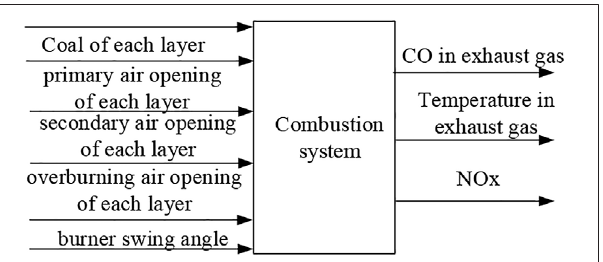
FIGURE 2 | Input and output variables of the boiler combustion